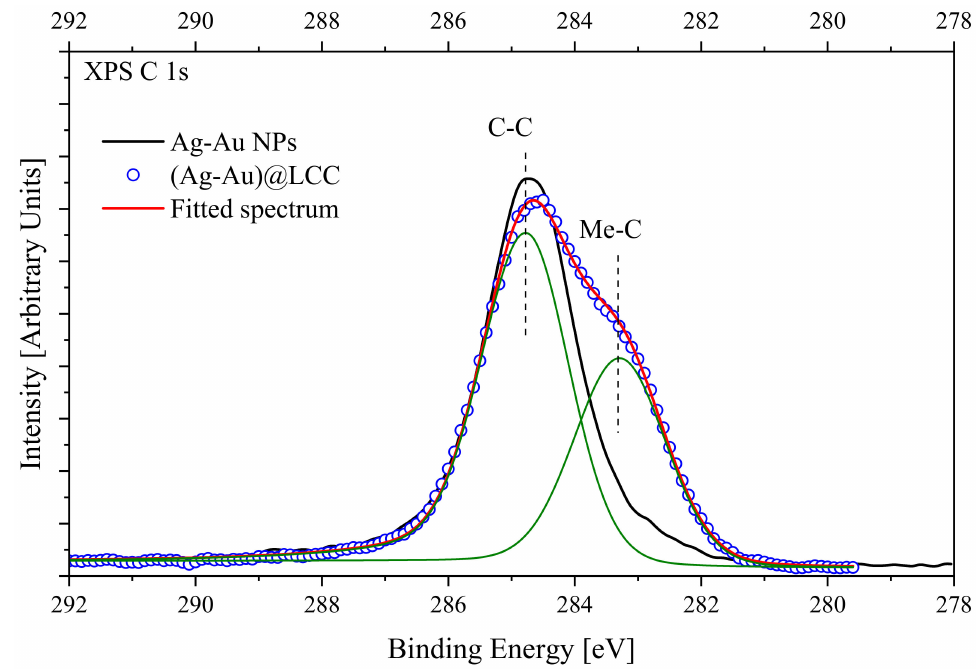
Figure 6. XPS C 1s spectra of Ag-Au and